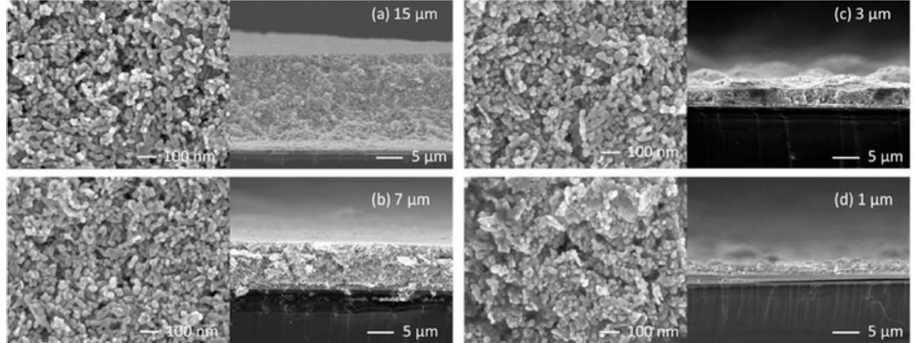
Figure 6. SEM top view and cross section images of different screen printed ZnO film thickness a ) 15,